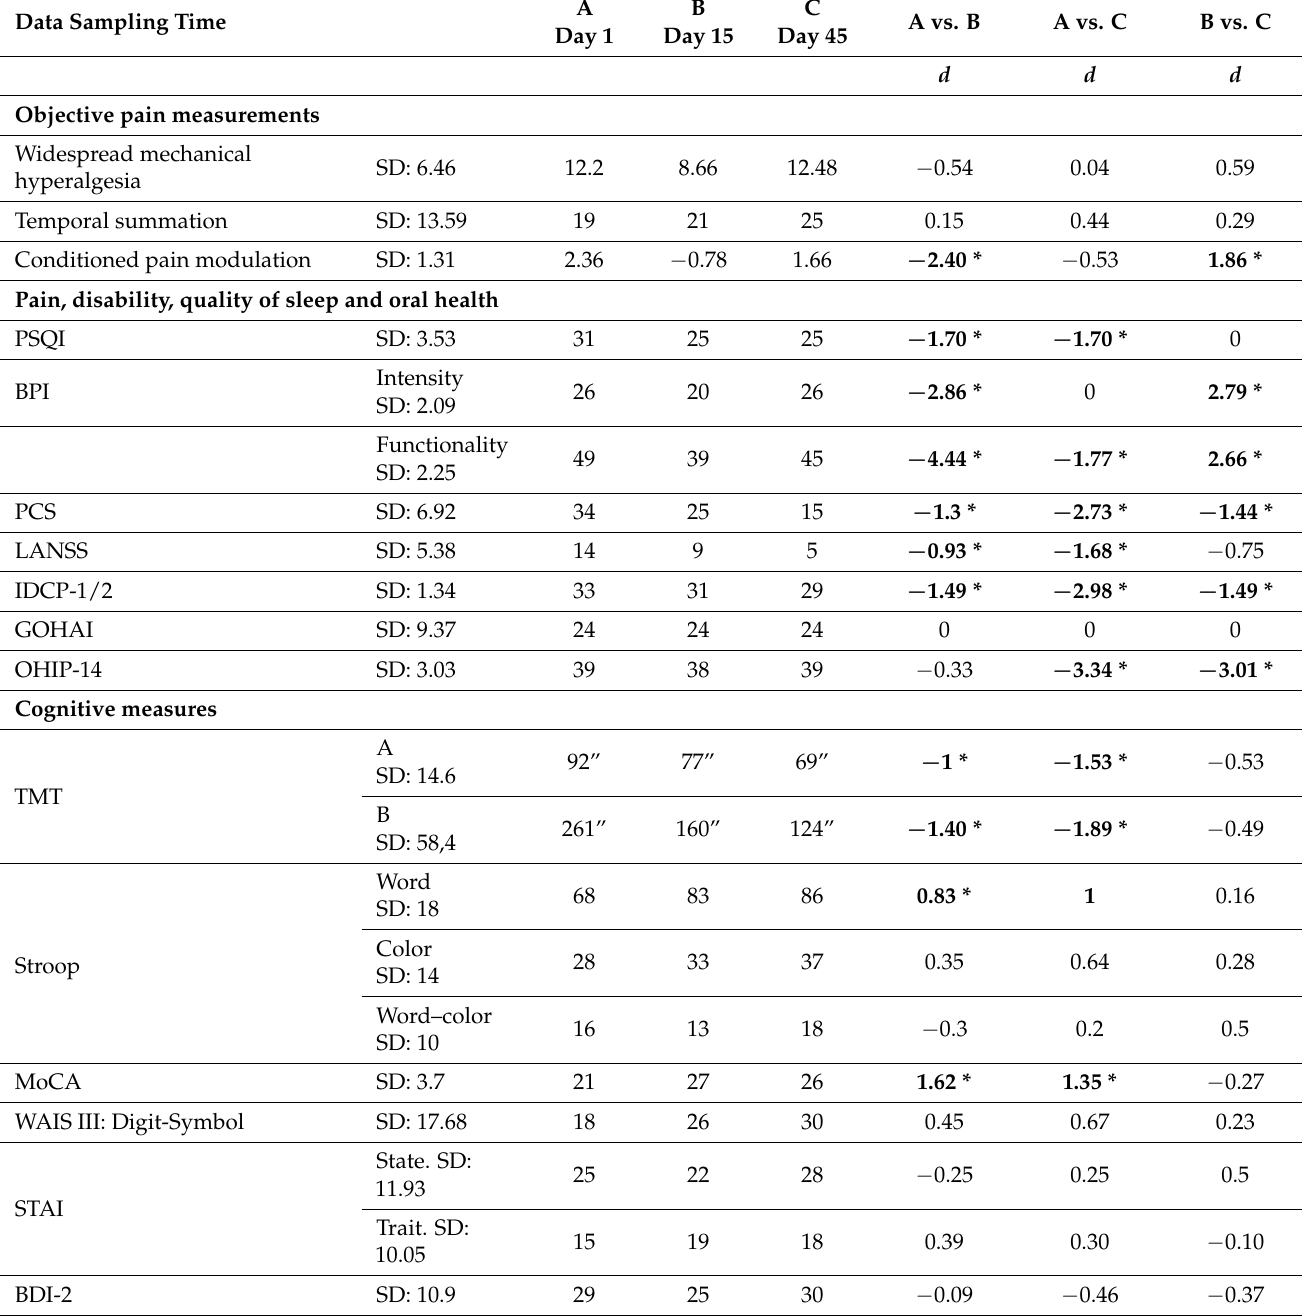
Table 1. Results and size of